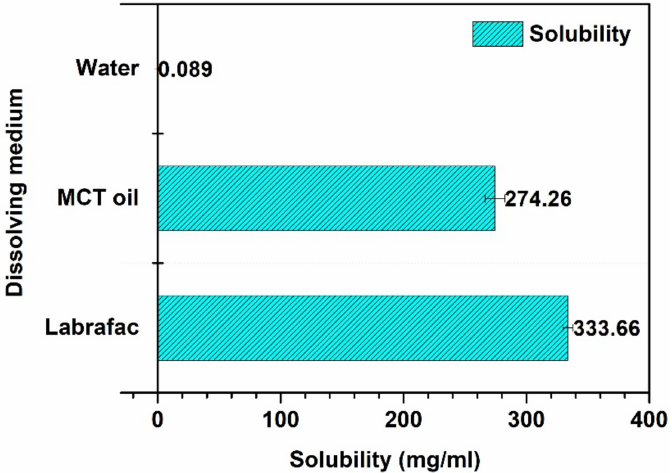
Figure 1. Solubility profile of efavirenz in Labrafac Lipophile 1349, MCT oil and HPLC-grade